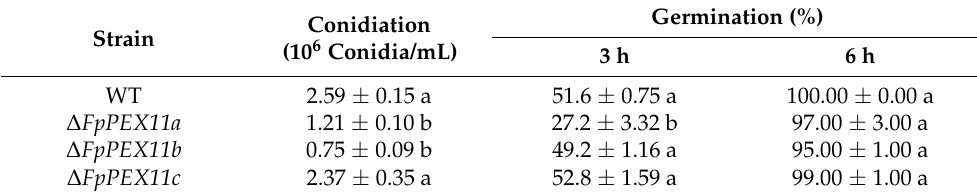
Table 1. Conidiation and conidial germination for 3 h or 6 h in the WT and ∆ FpPEX11 strains. Strain